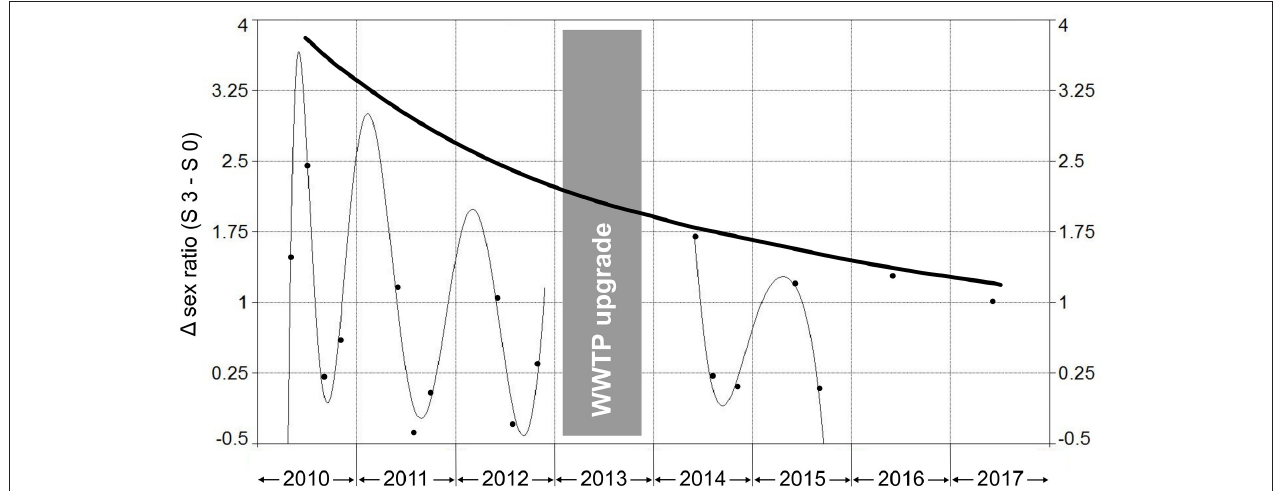
FIGURE 3 | Differences between sex ratio at sampling site S 3 (downstream of the WWTP) and S 0 (upstream of the WWTP) prior to (2010–2012) and after (2014–2017) the upgrade. Non-linear regression analysis by Fourier series polynomial 7 × 2 ( r 2 =